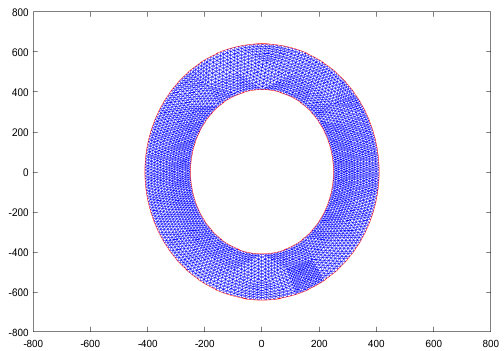
Fig. 2: Tire sidewall mesh showing 3672 nodes and 6912 triangle